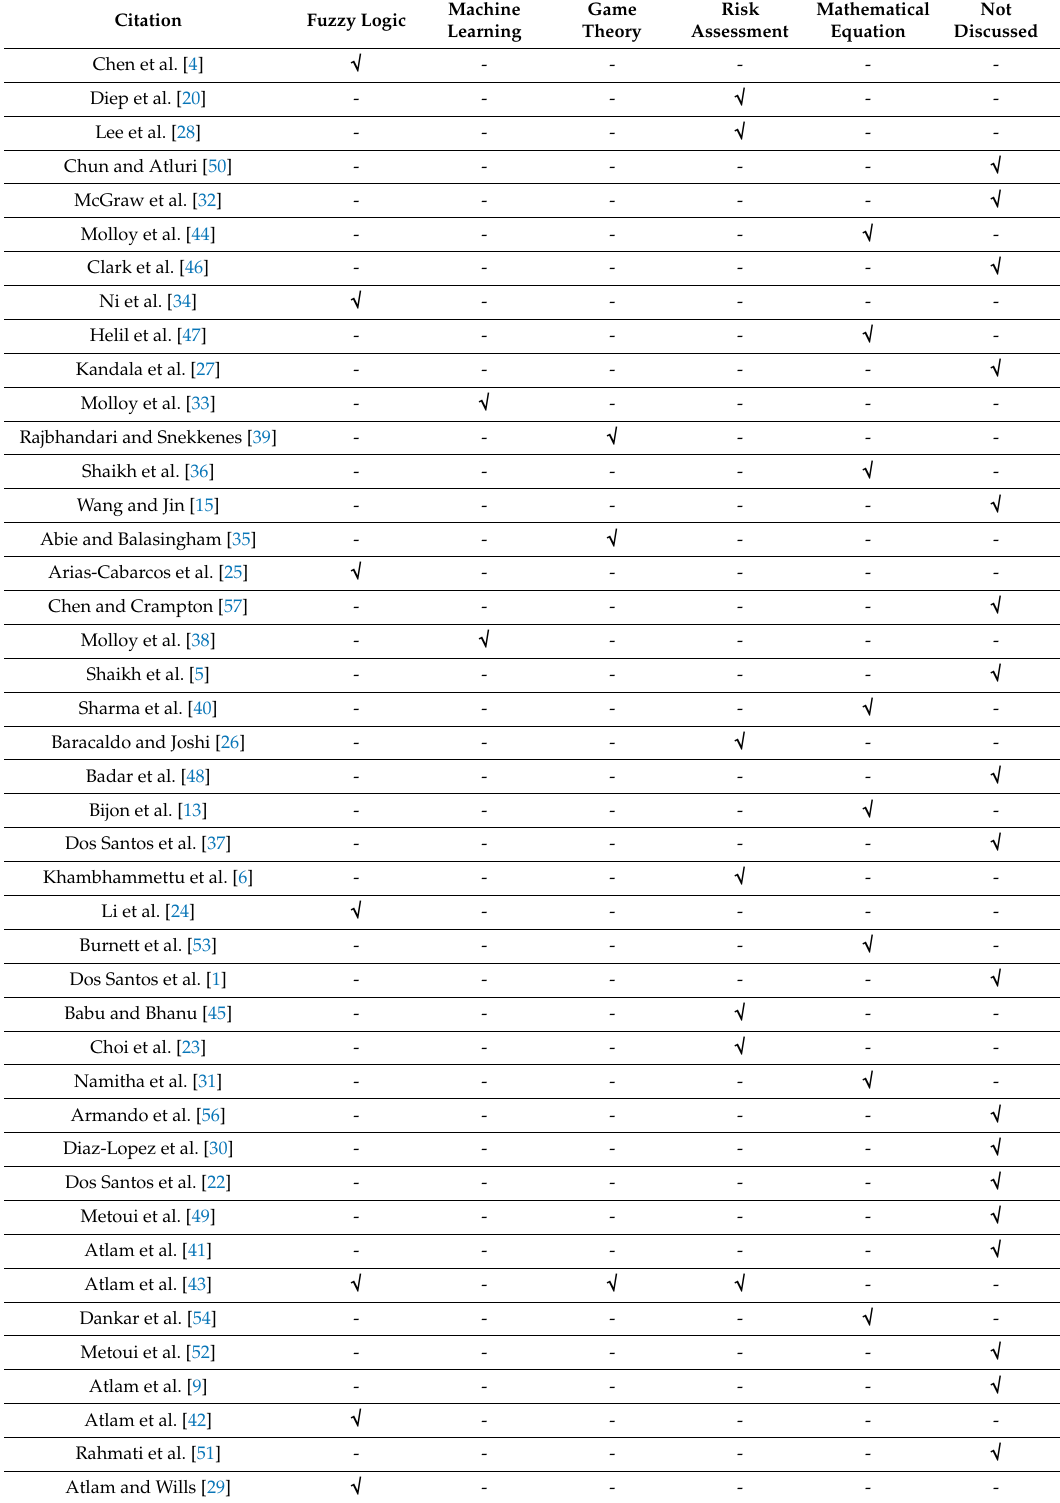
Table 6. Risk estimation techniques used in retrieved / analyzed publications of risk-based access control